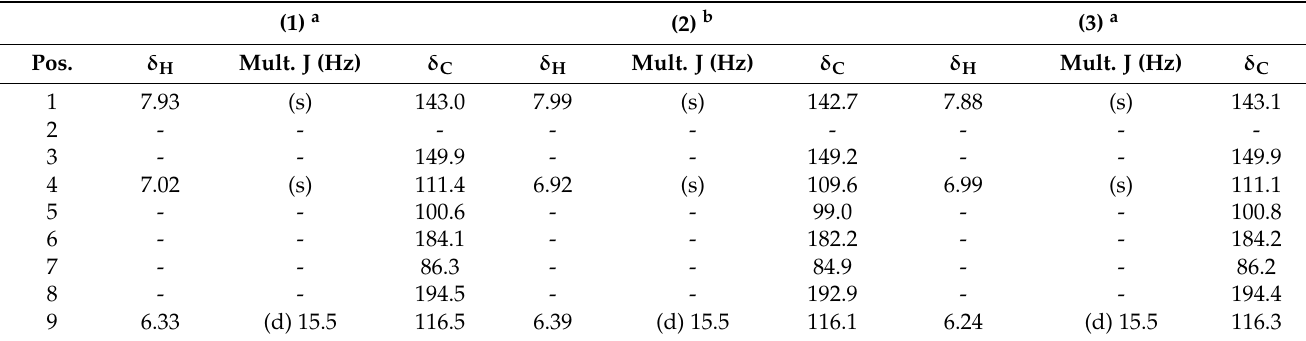
Table 1. NMR Table 1H and 13 C of penazaphilones J-L ( 1 – 3 ) (600